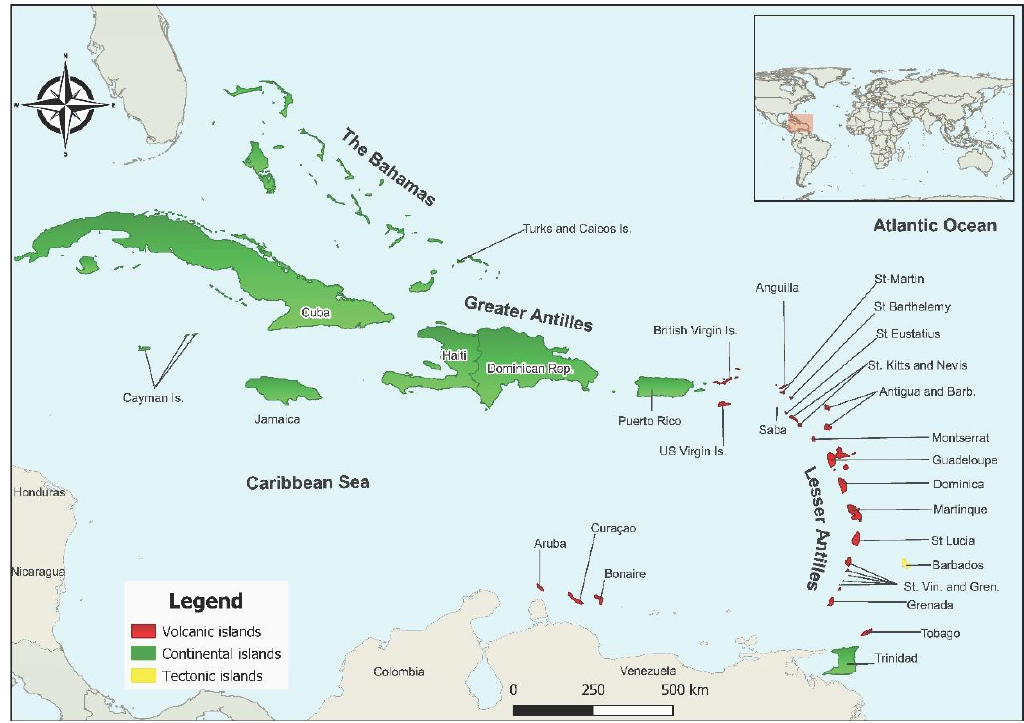
Figure 1. Map highlighting the geological history of the islands of the Caribbean. The Caribbean is composed of three island groups—The Bahamas, Greater Antilles, and Lesser Antilles. Abbreviations: St. Vincent and the Grenadines (St. Vin. and Gren.); Dominican Republic (Dominican Rep.) Antigua and Barbuda (Antigua and Barb.). Map created using QGIS 3.28.1.